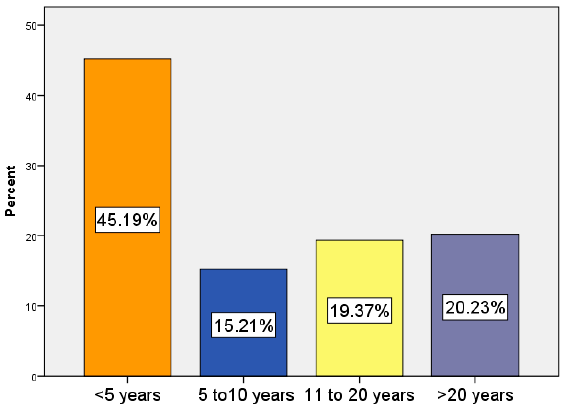
Figure 5. Work experience distribution.